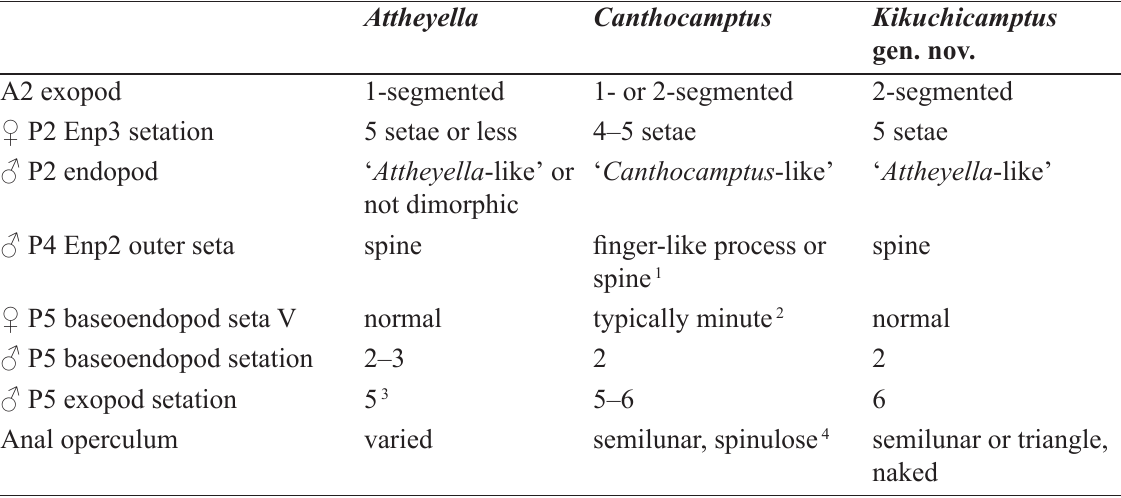
Table 7. Differences between Attheyella Brady, 1880, Canthocamptus Westwood, 1836 and Kikuchicamptus gen.